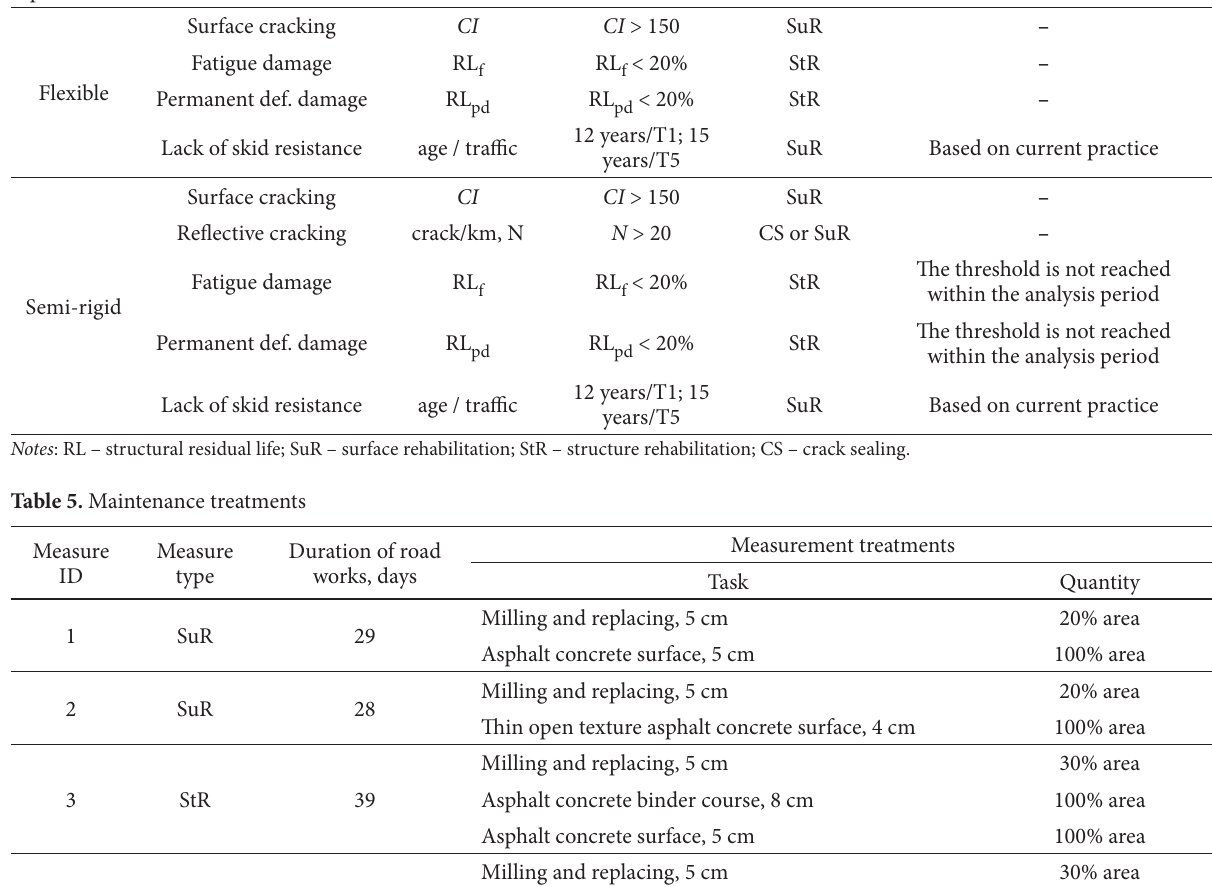
Table 4. Maintenance thresholds and types of maintenance measures Type of pavement